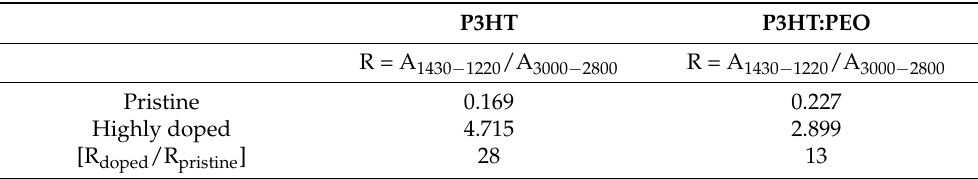
Table 3. Ratios of the integrated band intensities in the CC stretching region (1430–1220 cm − 1 ) and of the whole CH stretching intensity (3000–2800 cm − 1 ) for pristine and doped